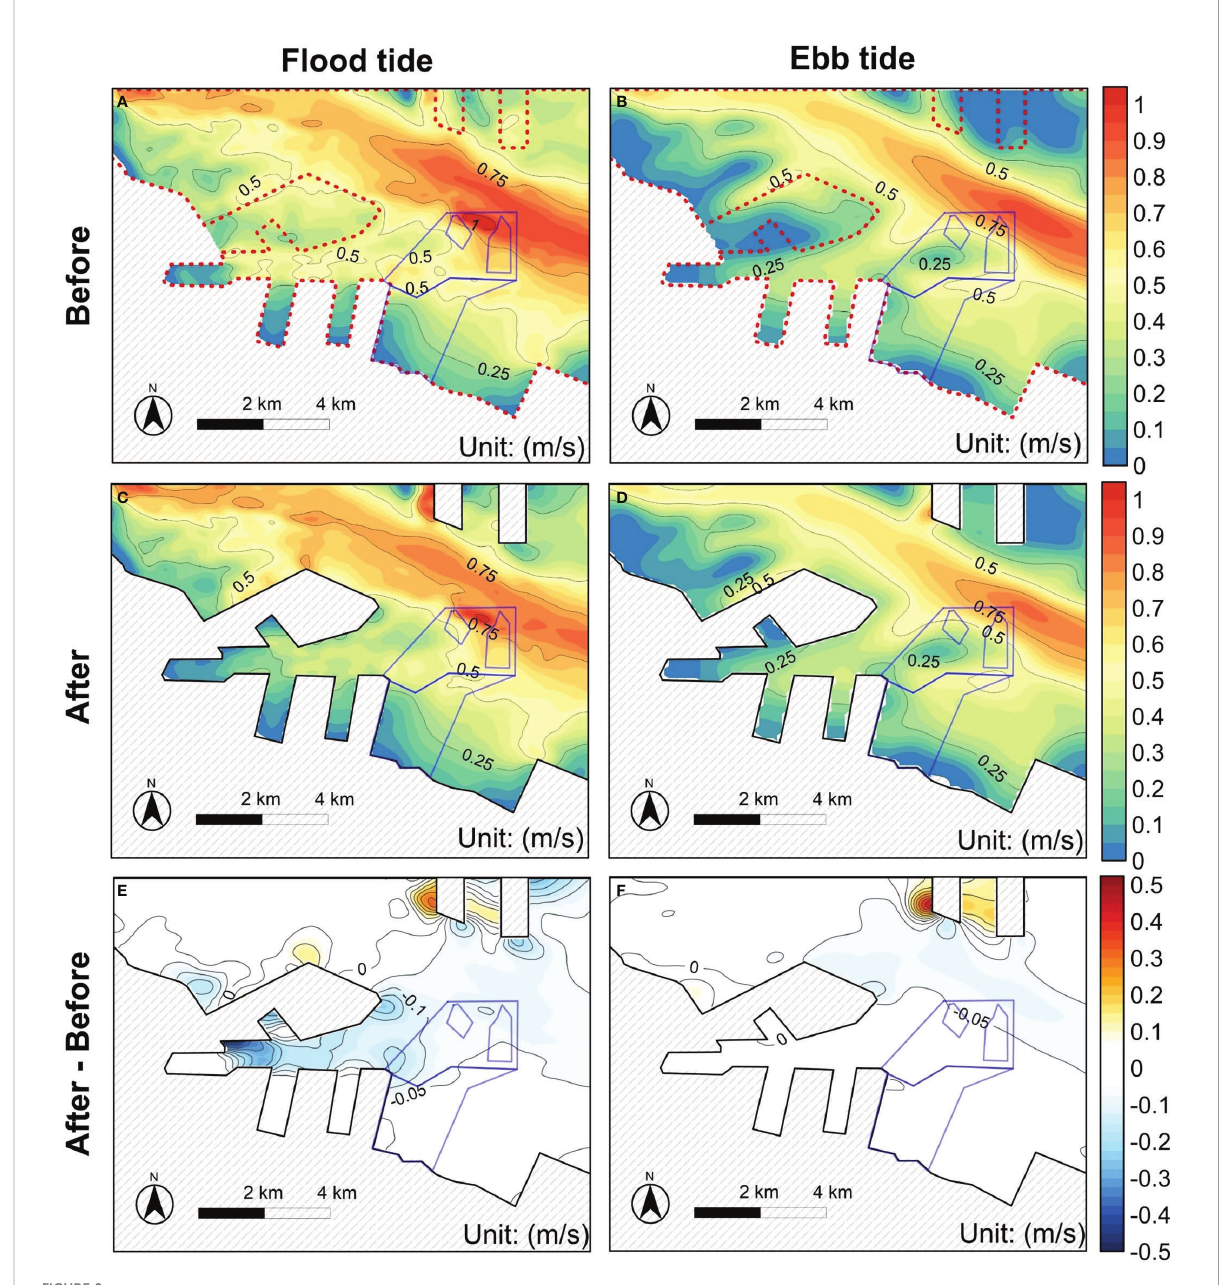
FIGURE 9 Comparison of bottom fl ow velocity during spring tide before and after construction of the project. The locations of oyster reefs and their subdivisions are marked on the fi gures with solid blue lines. Bottom fl ow velocity distribution during (A) peak fl ood tide and (B) peak ebb tide of the spring tide before construction of the project. Bottom fl ow velocity distribution during (C) peak fl ood tide and (D) peak ebb tide of the spring tide after construction of the project. Difference in bottom fl ow velocity distribution during (E) peak fl ood tide and (F) peak ebb tide of the spring tide before and after construction ( fl ow velocity before construction minus fl ow velocity after